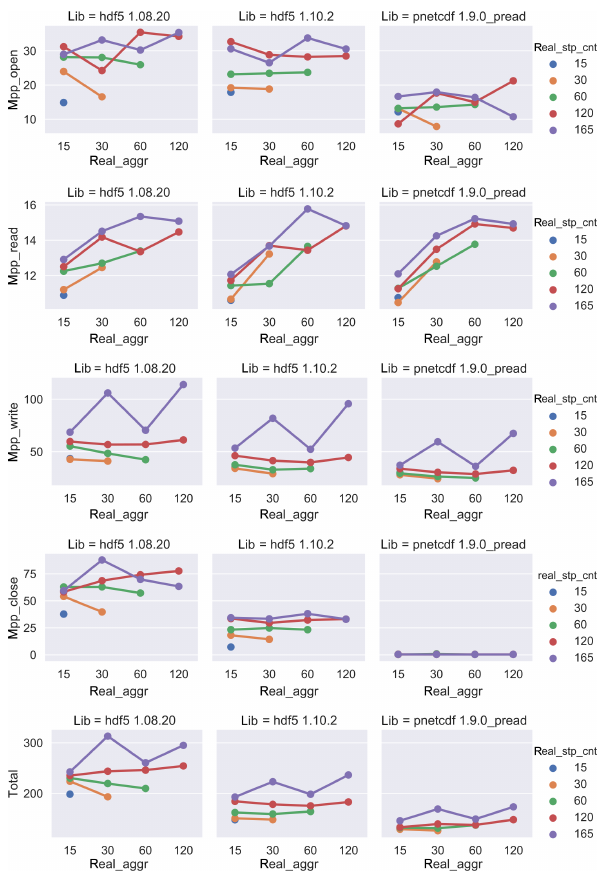
Figure 8. The I / O performance of 240 PE benchmarks with differ- ent library/format bindings regarding to the number of aggregators and stripe counts.